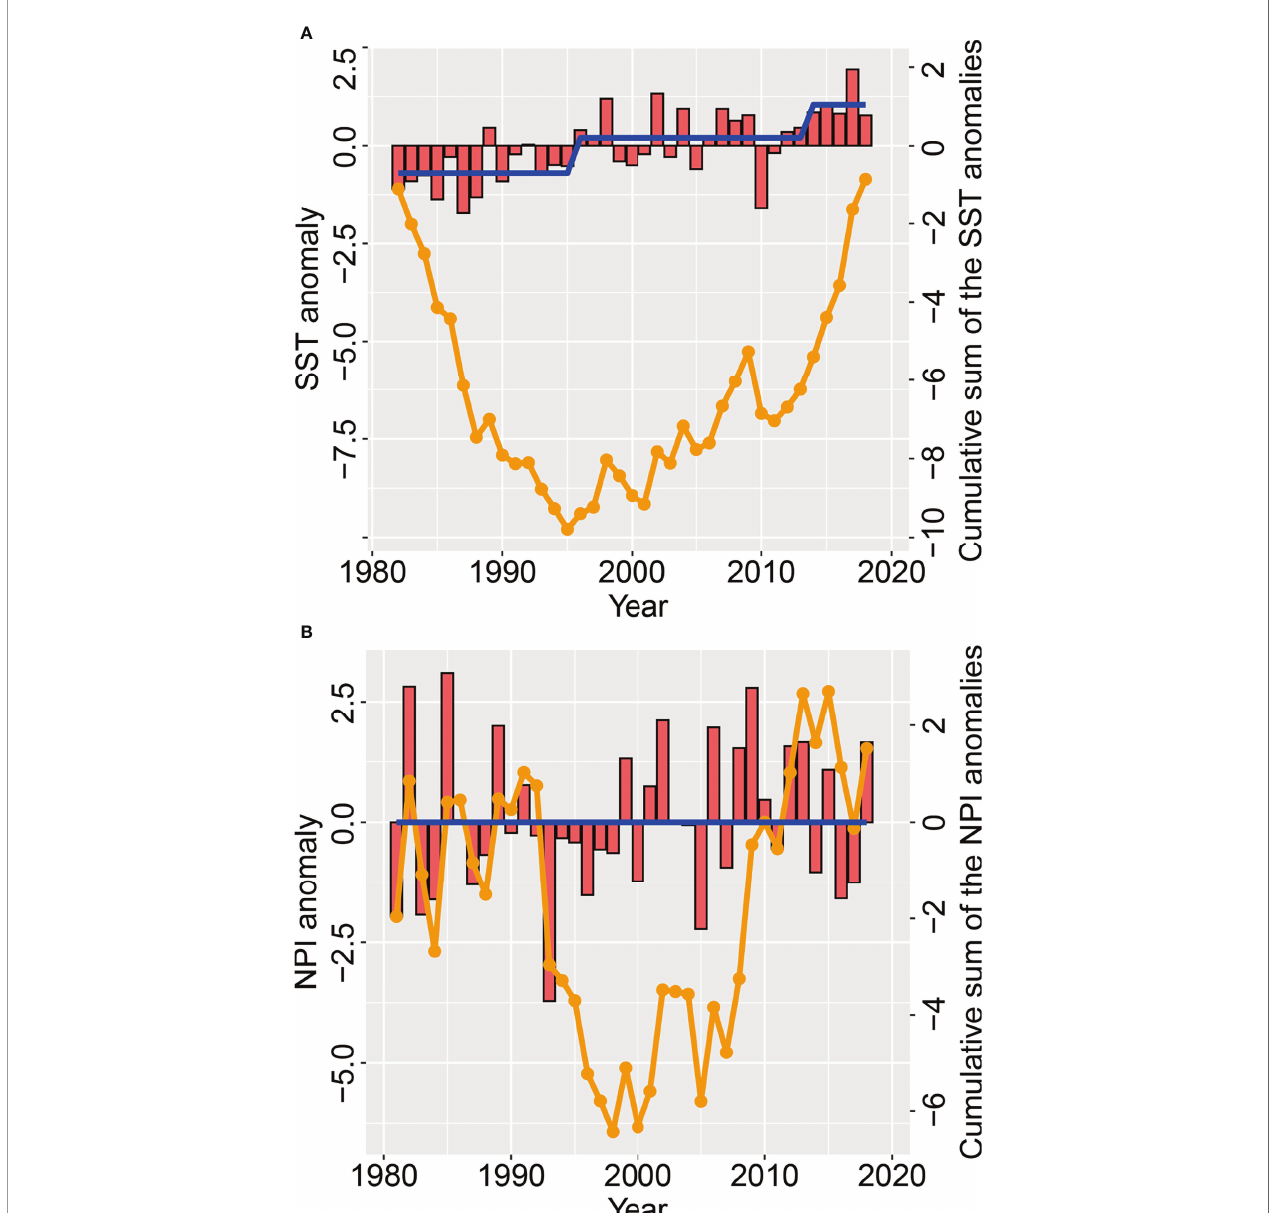
FIGURE 6 | Changes in (A) May sea surface temperature (red bars) anomalies (SSTA) and (B) spring North Paci fi c index (NPI) anomalies (red bars), as well as the cumulative sum of the NPI and SST anomalies (orange line), in the Bohai Sea over the period 1981 − 2018 The regime shift (blue line) in the NPI and SST is also